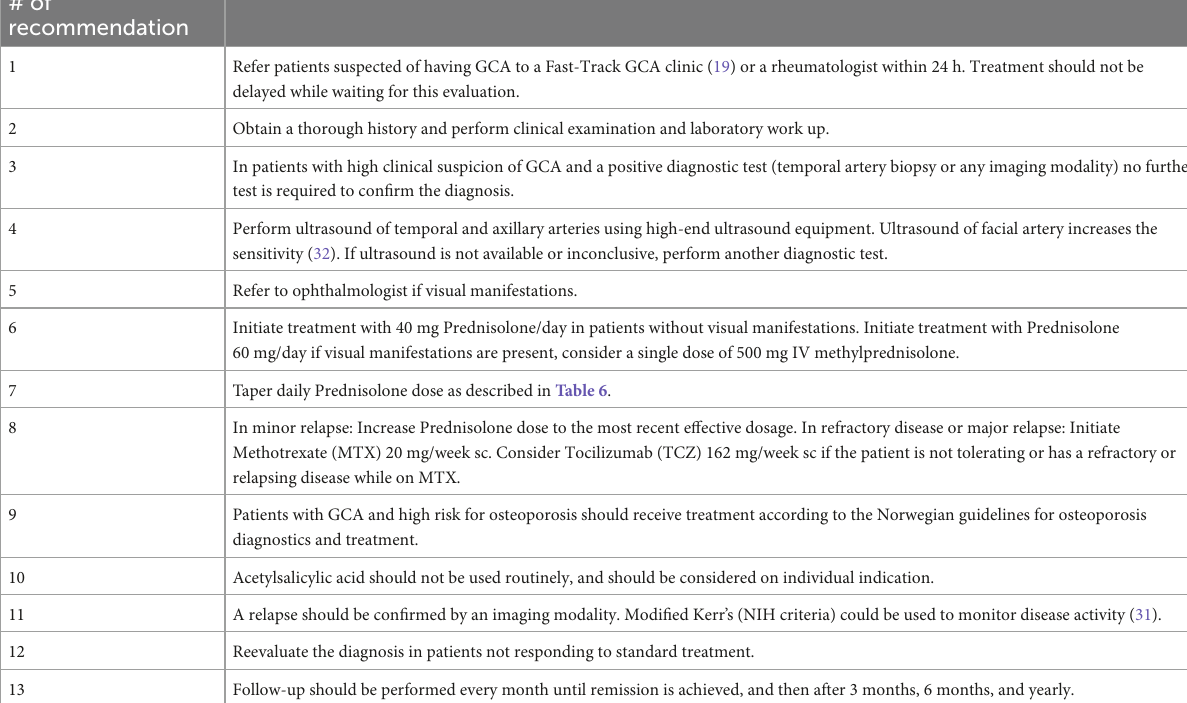
TABLE 5 Summary of the Norwegian society of rheumatology’s recommendations on diagnosis and treatment of patients with giant cell arteritis